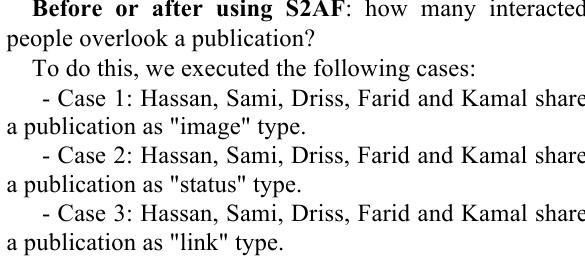
Figure.12. Example of a real social network on Facebook with 5 real users